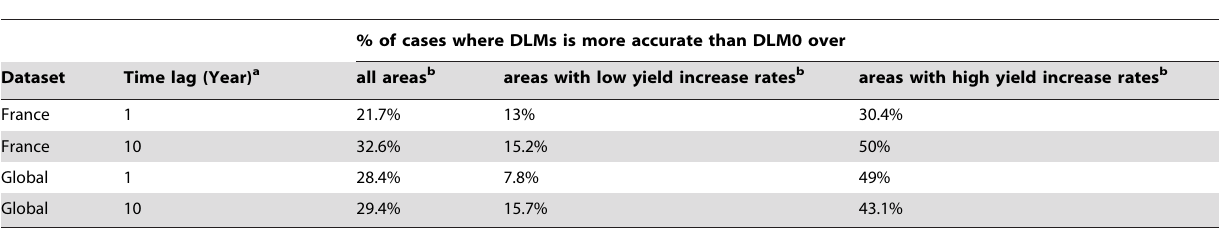
Table 4. Percentages of geographical areas ( de´partements for the dataset France, and countries for the global dataset) where the model DLMs has a lower RMSEP than the model DLM0.